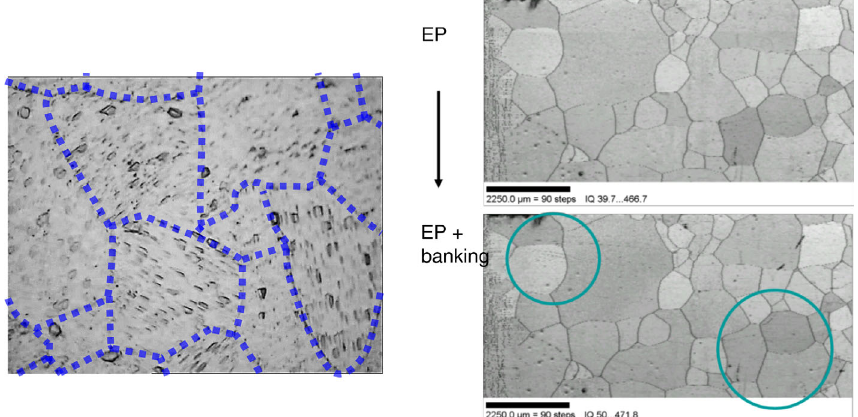
FIG. 5. Left: Etching figures revealing dislocation arrays on as-received Nb sheet. The blue dotted line marks grain boundary locations. Note how the etching figures obviously depend on crystalline orientation. Right: Crystalline image quality index (see the text for explanation) as determined by EBSD. The darker areas show grains where the diffraction diagrams are distorted compared to the expected diagram from a “ perfect crystal. ” Note that not all the grains have the same relative quality, and that baking does not necessarily improve the local IQ (only 12% – 13% of the grains are affected by